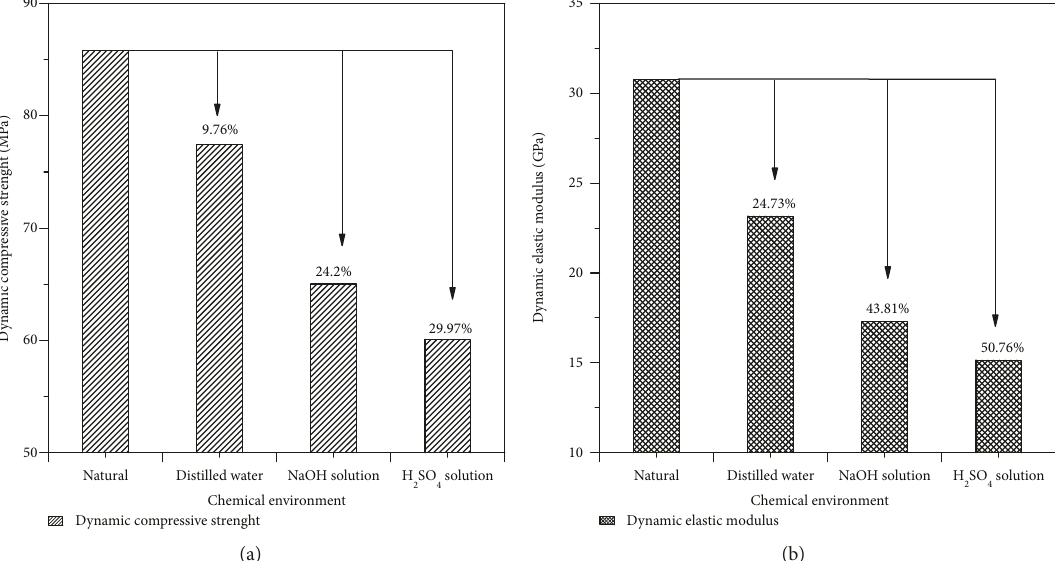
Figure 12: Reduction of dynamic compressive strength and elastic modulus of sandstone specimens subjected to di ff erent chemical solutions.